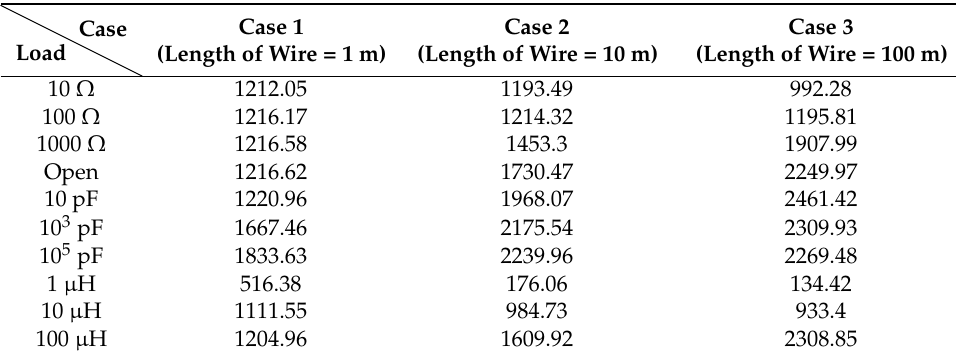
Table 6. The results in case 1 to 3 (Unit: V).